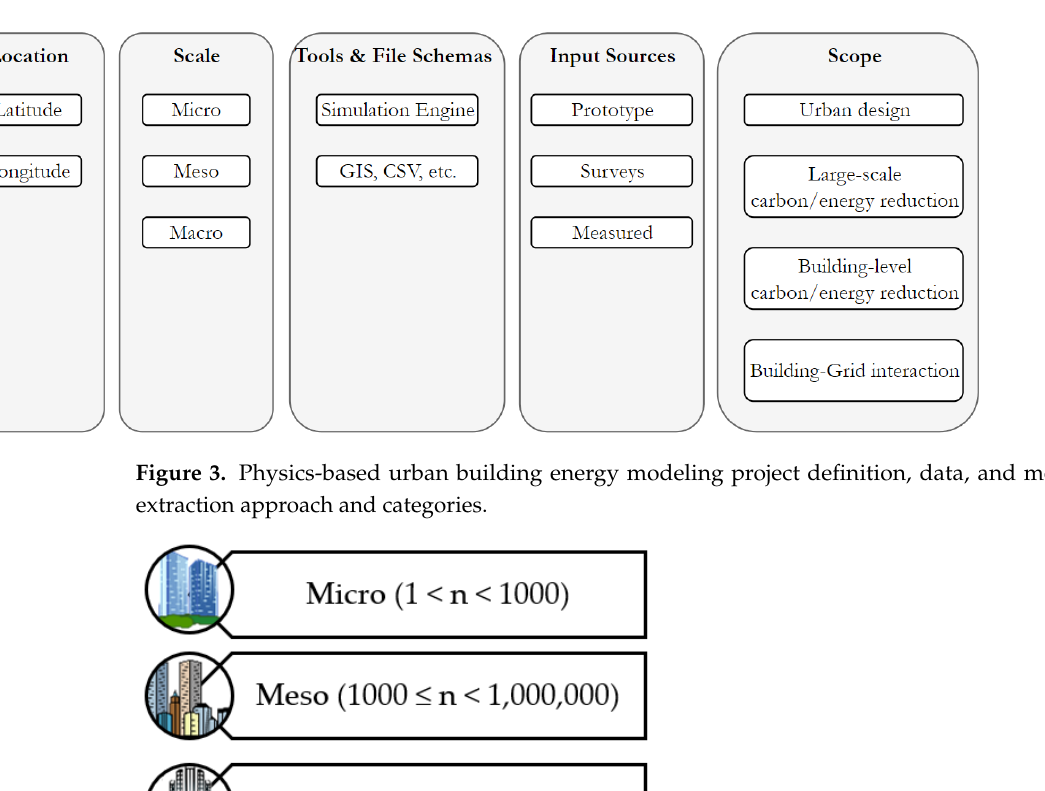
Figure 4. Suggested scaling categories for urban building energy modeling.